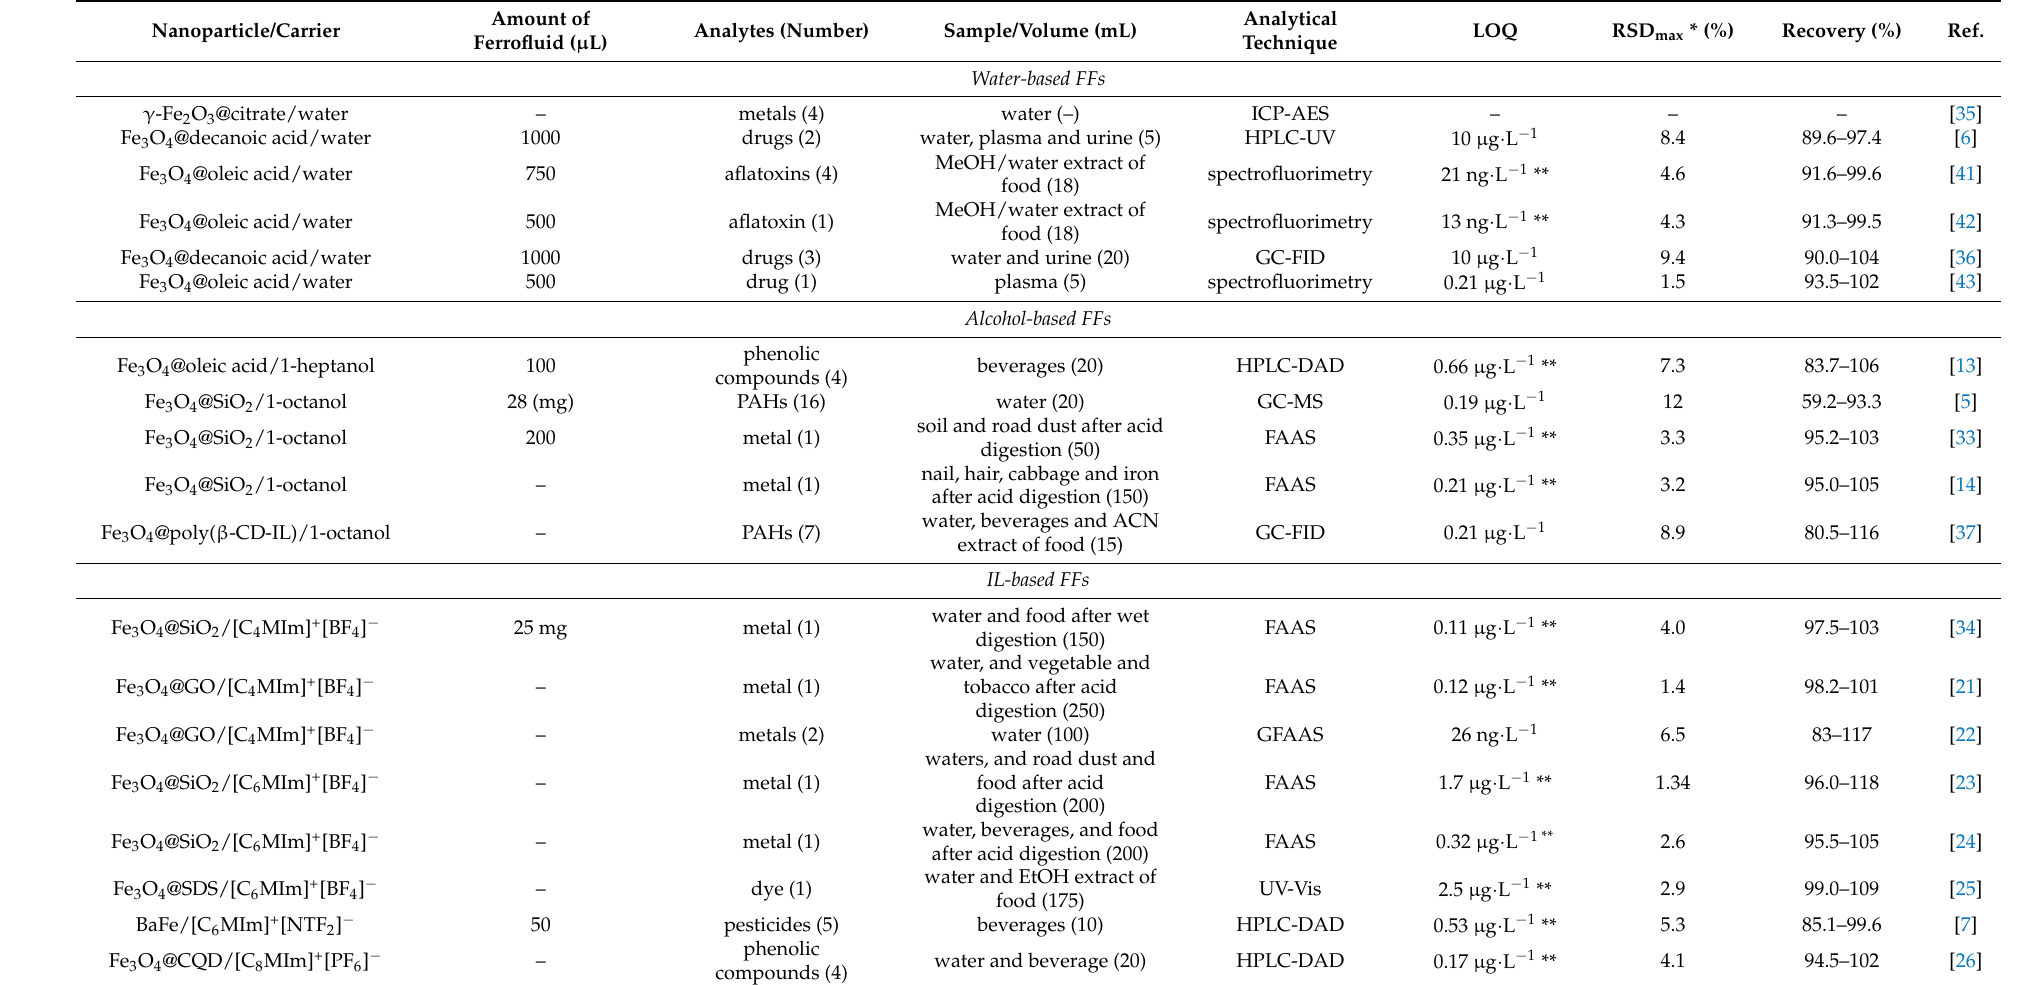
Table 1. Main analytical features of the reported FF-based extraction